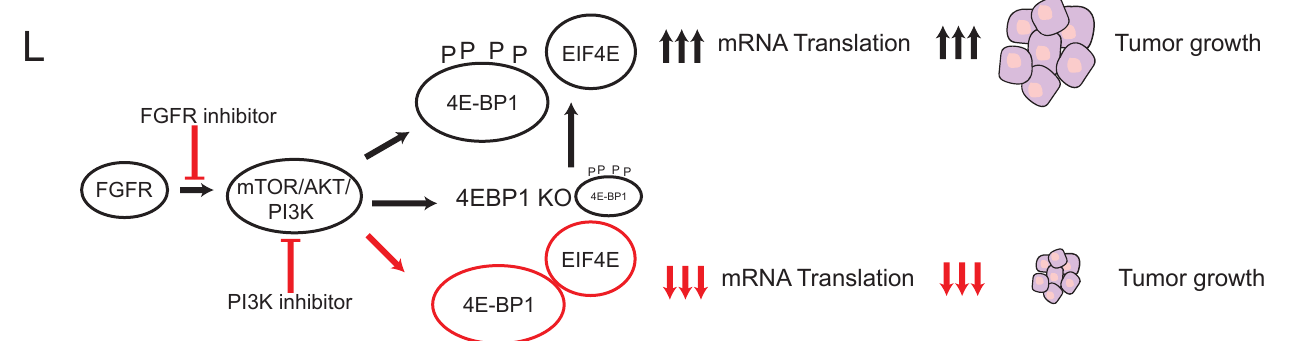
Figure 3. 4EBP1 Amplified tumors show increased sensitivity to FGFR1 and PI3K inhibition.